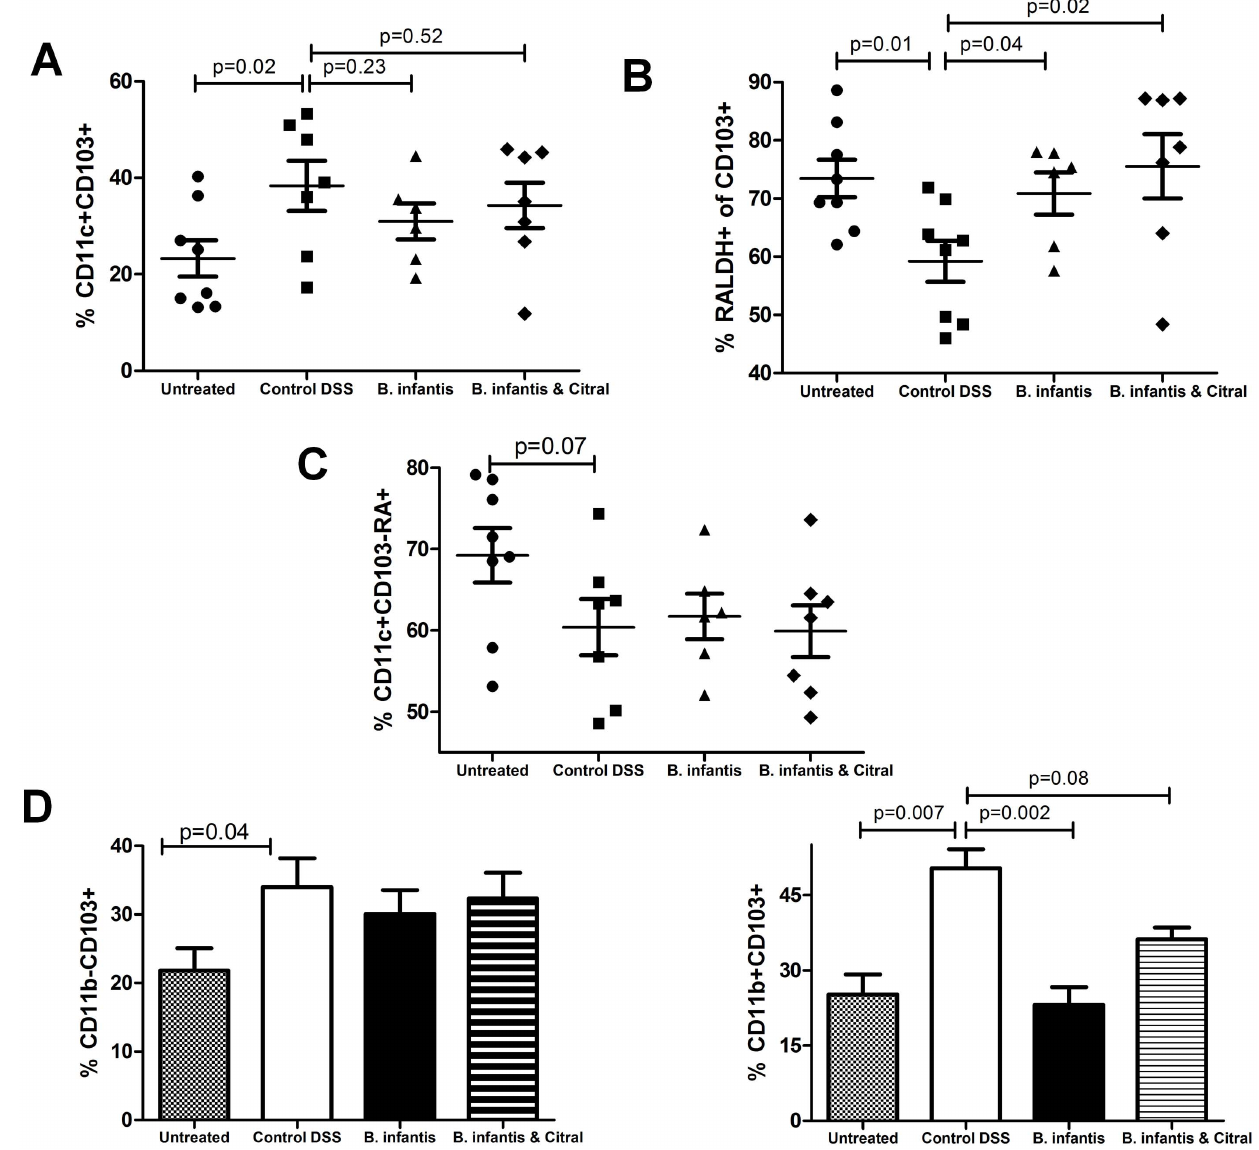
Figure 7. B.infantis suppresses the expansion of a pro-inflammatory dendritic cell phenotype within the LP. Untreated (n=8), DSS colitis (n=7), DSS and B. infantis treated (n=6) and DSS, B. infantis and citral treated animals (n=7) were compared for dendritic cell subsets within the LP. ( a ) The proportion of CD103 + dendritic cells within the LP was increased for all groups with DSS-induced colitis. ( b ) However, the CD103 + cells expressing RALDH was significantly reduced in the inflamed LP, which was normalized by B. infantis feeding. ( c ) The CD11c + CD103 2 RALDH + cell numbers were reduced in the control DSS group and B. infantis did not reverse this suppression. ( d ) The increase in CD103 + dendritic cells in the inflamed LP primarily consists of CD11b + CD103 + dendritic cells, while B. infantis feeding was associated with an increase in CD11b 2 CD103 + dendritic cells. Statistical significance for (a), (b) and (c) was estimated using the non-parametric Mann-Whitney test, while (d) statistics were determined using the parametric unpaired student